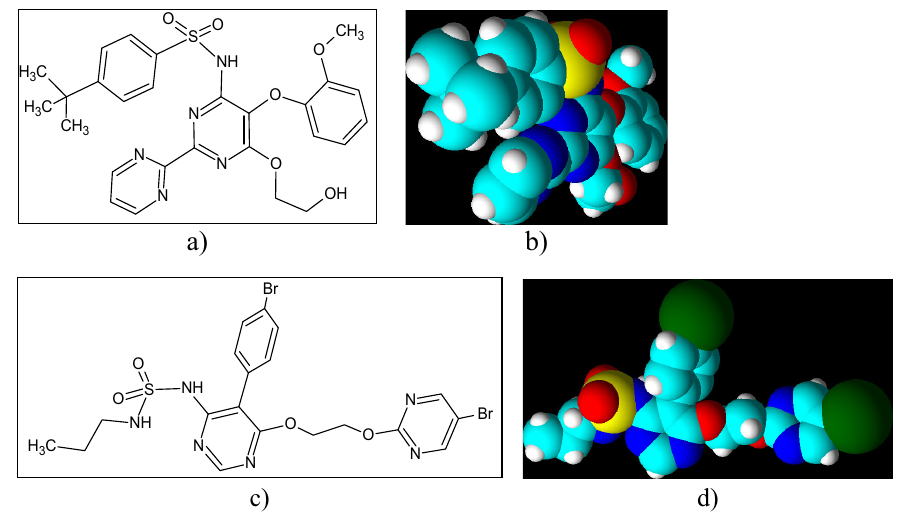
Figure 12: Structures of the ET - I antagonists: ( a ) Bosentan ( without explicit hydrogens ) ; ( b ) Bosentan space - fi lling model; ( c ) Mecitentan; and ( d ) Mecitentan space - fi lling model.